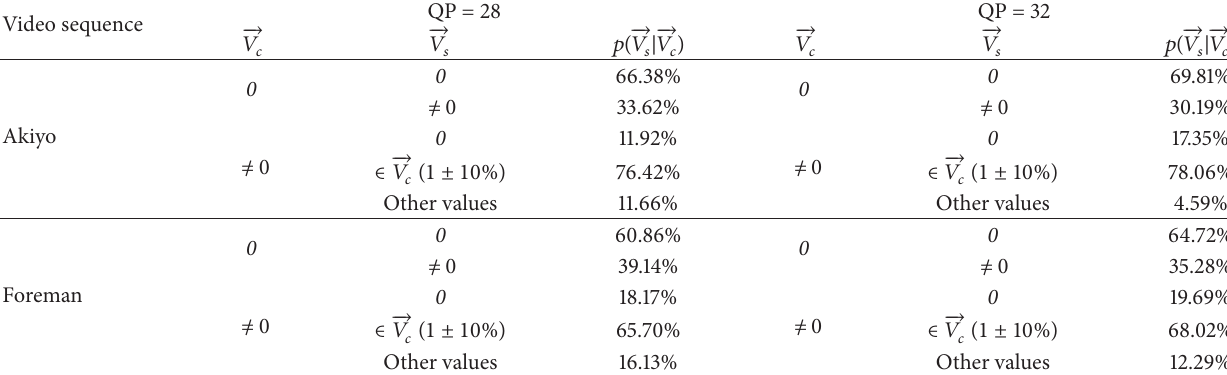
Table 1: Probability of MV with the same position.